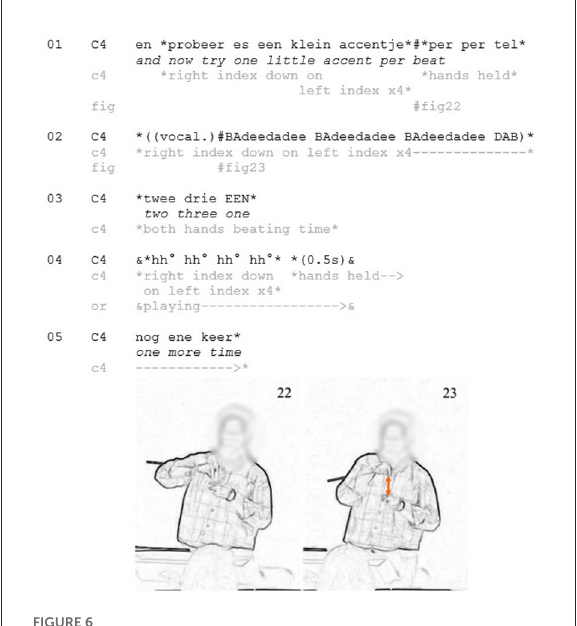
FIGURE6 Example 6 -